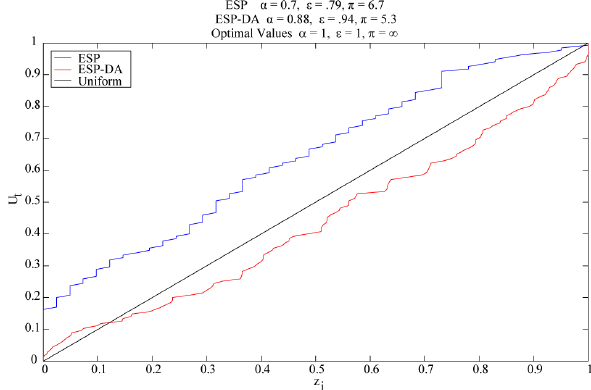
Fig. 10. Q-Q plot of the seasonal volumetric flow predictions for all 15 basins beginning in March, April and May during the years 2003, 2004 and